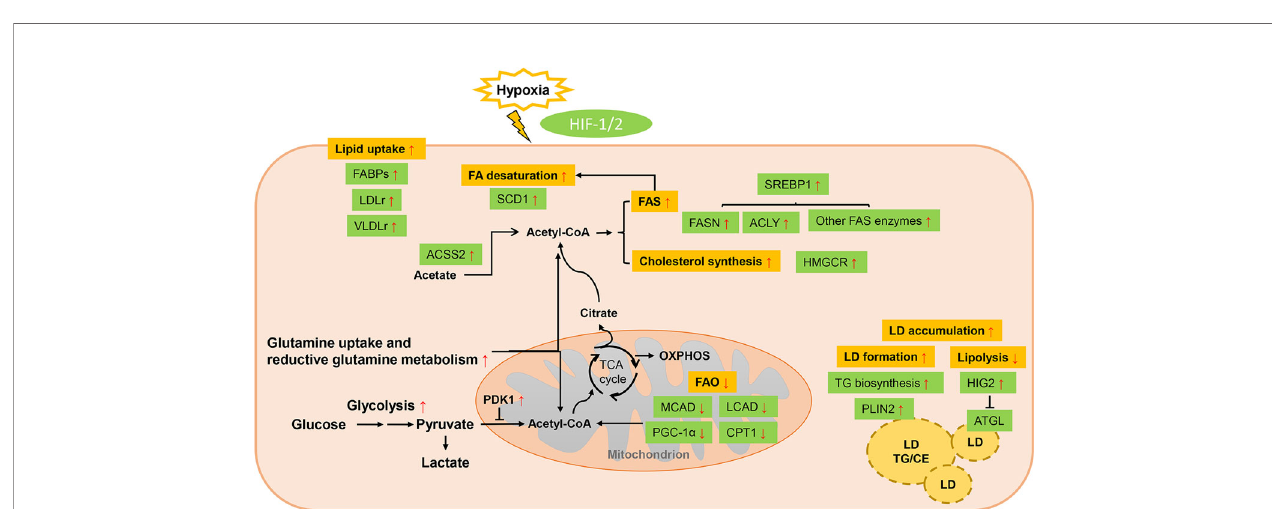
FIGURE 2 | Lipid metabolism reprogramming of cancer cells under hypoxia. Response to hypoxia comprises a series of adaptive changes that are mainly regulated at the transcriptional level by the family of hypoxia-inducible factors (HIFs). HIF can induce a lipogenic cancer cell phenotype via enhancing lipid uptake, synthesis and storage while cutting down utilization. Uptake of exogenous lipids are promoted by enhanced expression of FABPs and LDLr/VLDLr. The conversion of glycolysis- derived pyruvate to acetyl-CoA is impaired due to the overexpressed PDK1 while ACSS2-mediated acetate metabolism and HIF-dependent stimulation of reductive glutamine metabolism function as important source of lipid precursors. De novo FA synthesis is favored by HIF-1 through upregulated SREBP-1, which enhance the expression of lipogenic enzymes. Cholesterol cynthesis is also enhanced with increased acitivity of HMGCR. Though the activity of SCD1 is restrained under hypoxia, HIF can elevate its expression to counteract this effect. Increased LDs accumulation and restricted lipolysis are other strategies employed by hypoxic cancers to avoid lipotoxicity. However, FA oxidation is inhibited by HIF through downregulating related